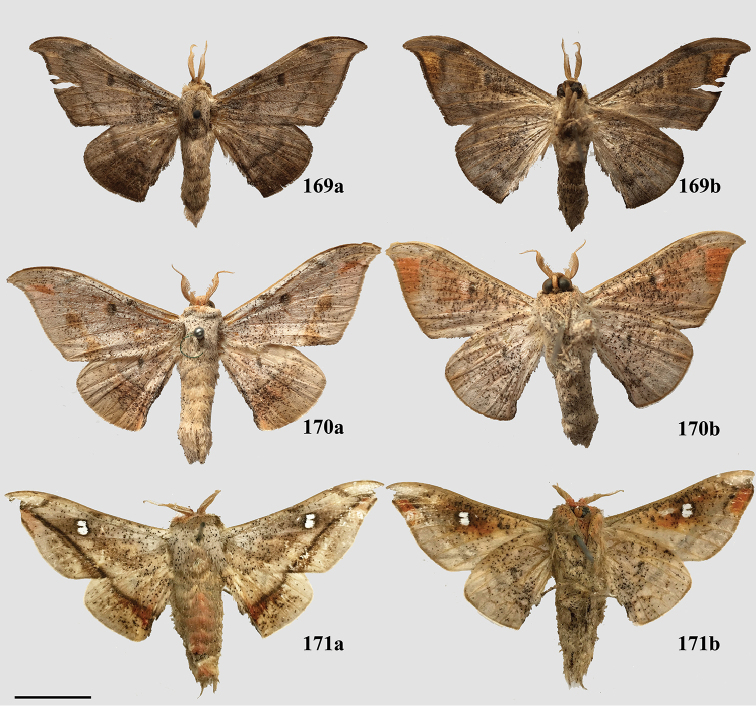
Lectotypes and neotype designated in the present work for Cicinninaea dorsal b ventral. See annotations in Section 4 for complete label data for all lectotypes and the neotype. All specimens are male. 169Cicinnussolvens Dyar, lectotype 170Cicinnustuisana Schaus, lectotype 171Mimallodespecta Walker (= Cicinnusdespecta), neotype. Scale bar: 1 cm.